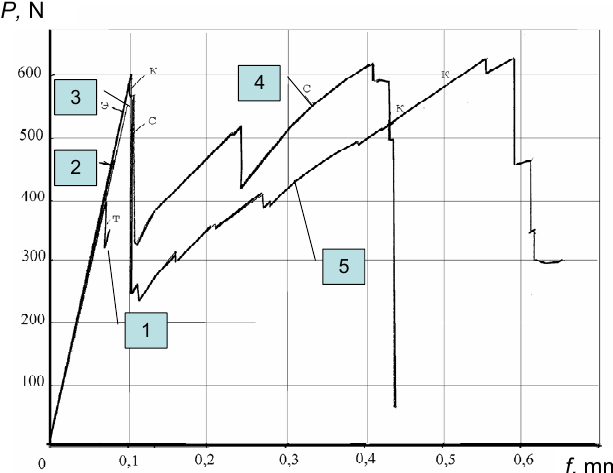
Figure 3. Deformation curves of the reinforced laminated glass composites under the bending. (The data were received together with Dr. Zemtzov M.P. and Dr. Skripchenko